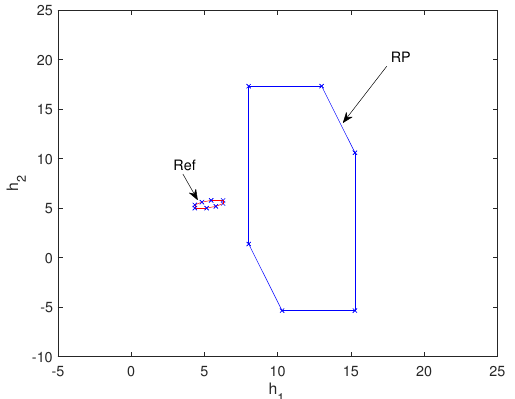
Figure 5. RP of two-tank